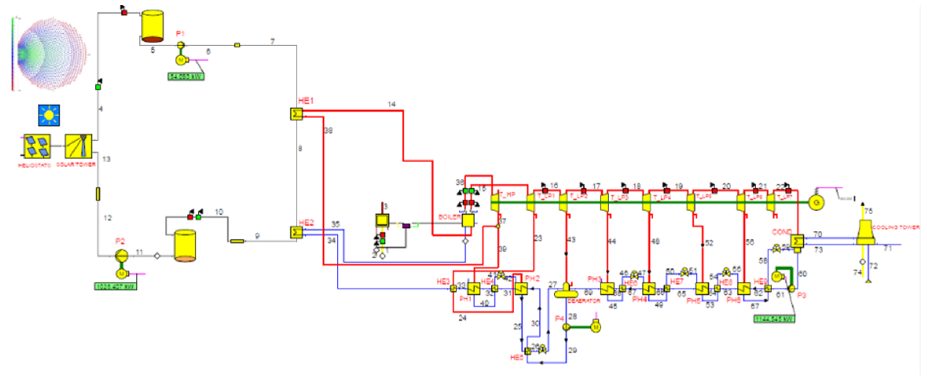
Figure 1. The proposed hybrid power plant that couples a coal plant with a solar power tower.